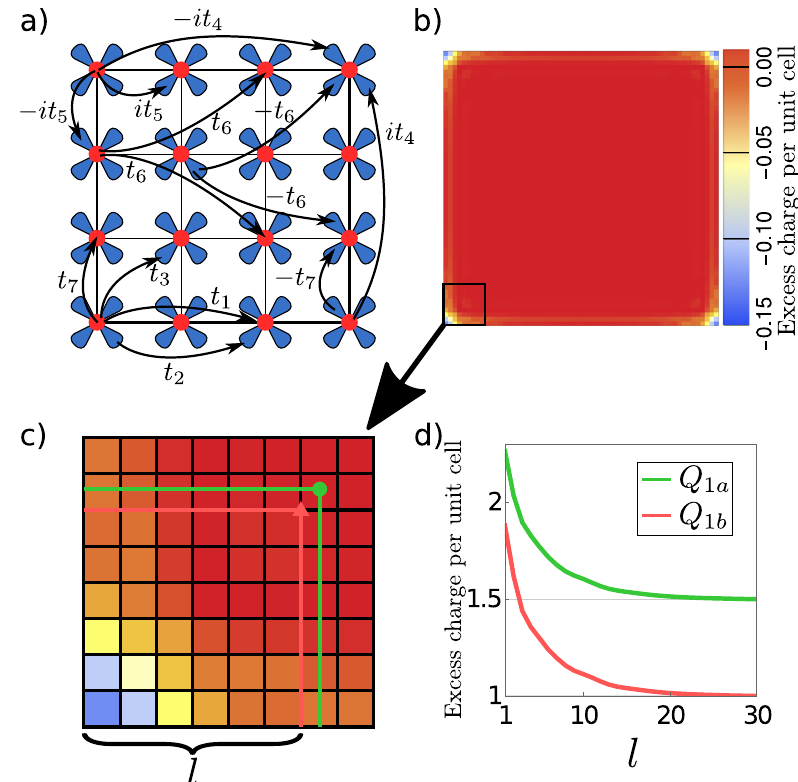
Fig. 5 Fragile topological phases and their quantized corner charges. a ) Schematic drawing of the hopping parameters for one spin sector of the C 4 symmetric fragile topological insulator model. b ) Charge density of a C 4 symmetric fragile topological insulator for a square sample of 60 by 60 unit cells. c ) Charge density of the lower left corner. The sum of the charge in the red and green areas give the corner charges Q 1 a and Q 1 b , respectively. d ) Corner charges as a function of the size of the summed region l . The corner charges exponentially go to the values of 1.5 and 1. Charge density is calculated for t 1 = 0.25 , t 2 = − 0.4, t 3 = 0.55, t 4 = − 0.35 , t 5 = − 0.56, t 6 = 0.125, t 7 =